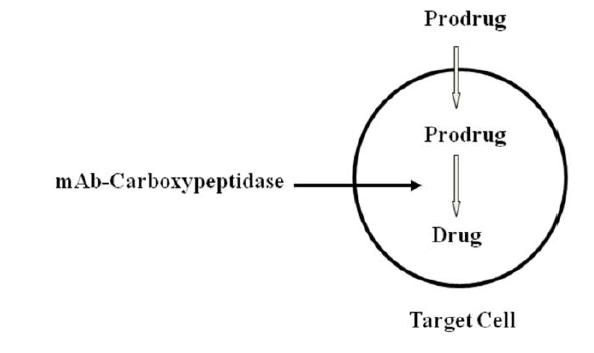
Figure 2. Illustration of the mechanism of mAb-effector fusion protein of a prodrug.